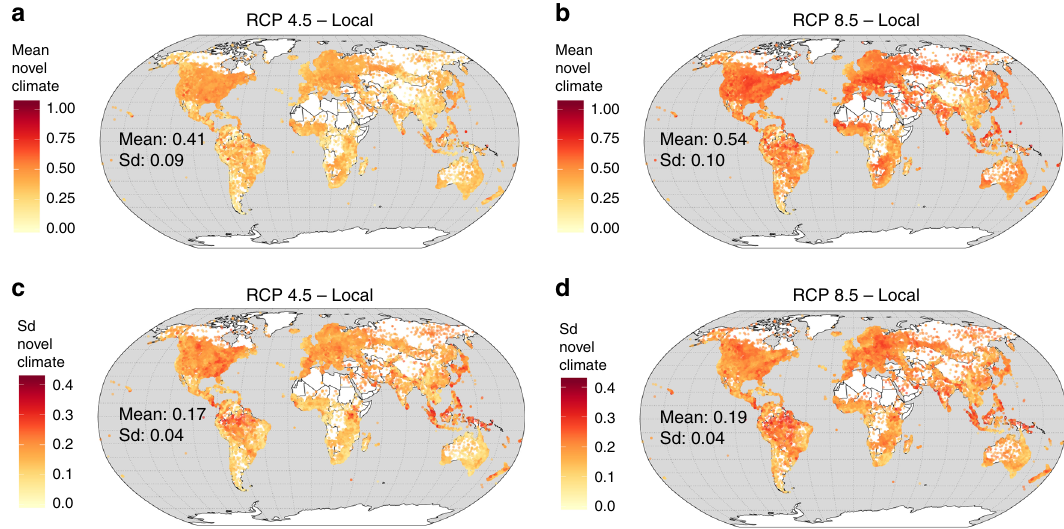
Fig. 2 Local-scale novel climate index of terrestrial protected areas worldwide. The local-scale novel climate index shows the proportion of raster cells inside a PA that hold climate classes in the future, which are currently not present in the PA. The mean ( a , b ) and standard deviation ( c , d ) of the local- scale novel climate index comprise future climate data from ten GCMs under RCP 4.5 and 8.5. Sd represents the variation of the local-scale novel climate index resulting from ten GCMs. a Mean of the local-scale novel climate index under RCP 4.5. b Mean of the local-scale novel climate index under RCP 8.5. c Sd of the local-scale novel climate index under RCP 4.5. d Sd of the local-scale novel climate index under RCP 8.5. For each metric in a – d , the mean and standard deviation across all 137,432 PA values are also given inside the global maps. Data on climate change metrics and other characteristics per PA are given as Supplementary Data 1. The maps were created using open-source software R